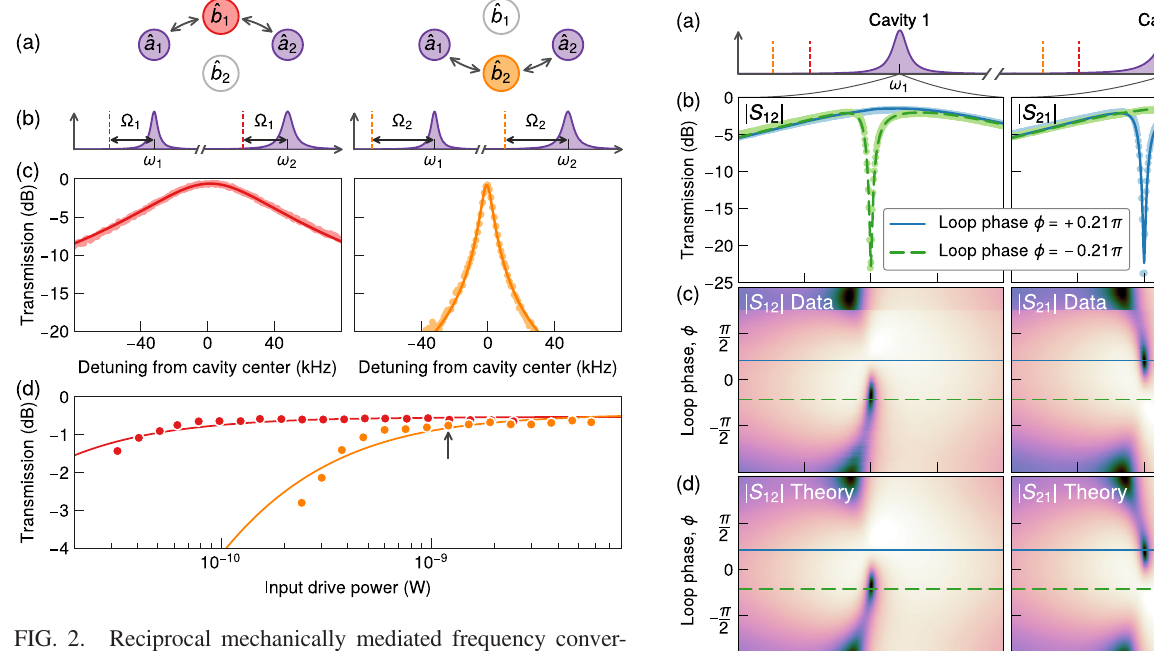
FIG. 2. Reciprocal mechanically mediated frequency conver- sion. (a) Mode-connection diagrams. Double-sided arrows in- dicate driven optomechanical interactions. (b) Frequency-space diagrams. A red-detuned drive applied at each cavity induces frequency conversion through one mechanical mode. Dashed lines indicate frequencies of microwave drives. (c) Measured magnitude of reciprocal transmission from cavity 2 to cavity 1 as a function of the probe detuning from cavity center for a particular drive power. Frequency conversion through the first mechanical mode is shown in red on the left and through the second mechanical mode in orange on the right. Solid lines are fits to Lorentzian line shapes. (d) Maximum transmission as a function of total input drive power for the first (red) and second (orange) mechanical modes. Solid lines are fits to a model described in Ref. [26]. The arrow indicates the drive power used in (c).